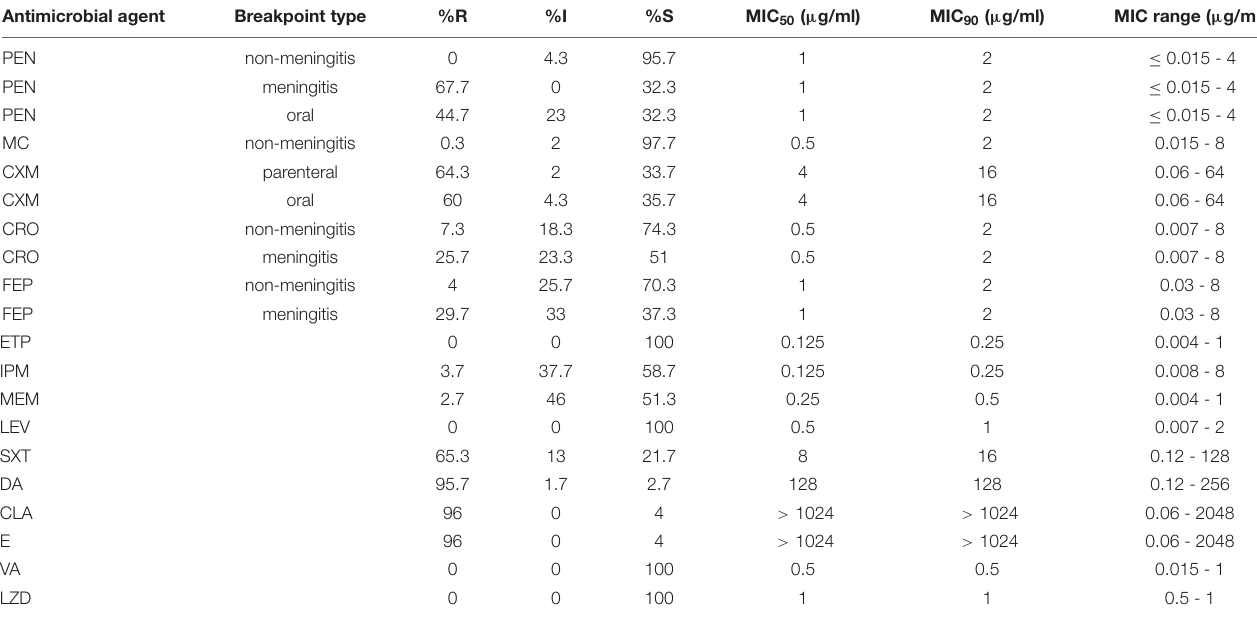
TABLE 3 | Antimicrobial susceptibility results of 300 S. pneumoniae isolates. Antimicrobial